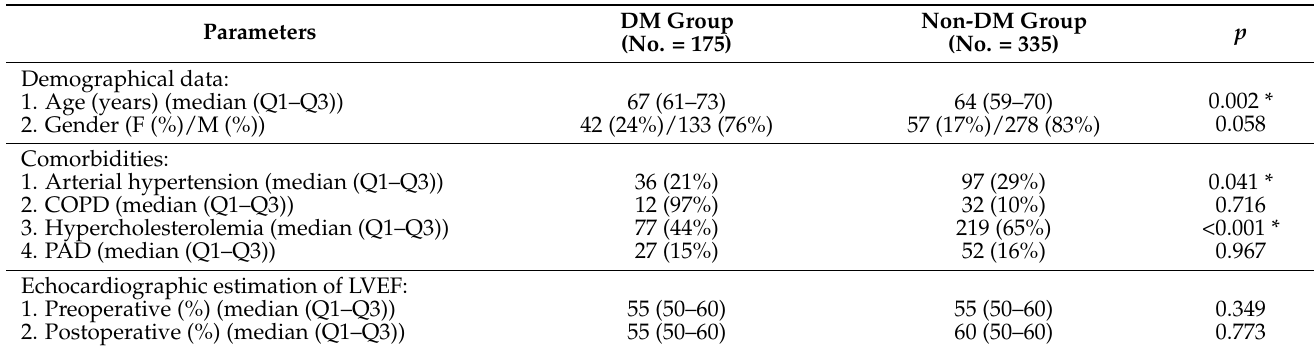
Table 1. Demographical and clinical preoperative characteristics.